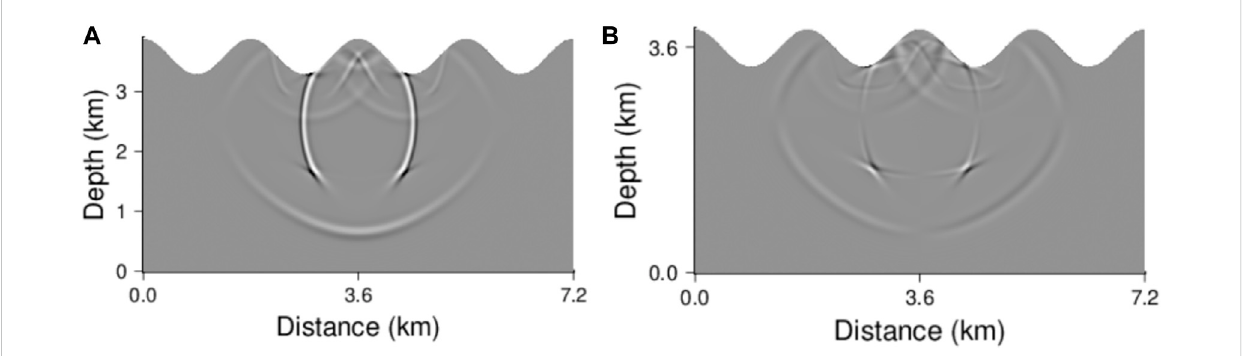
FIGURE 10 Snapshots of the elastic wave fi elds in anisotropic medium at t = 0.7 s (A) u 1 and (B) u 2 .